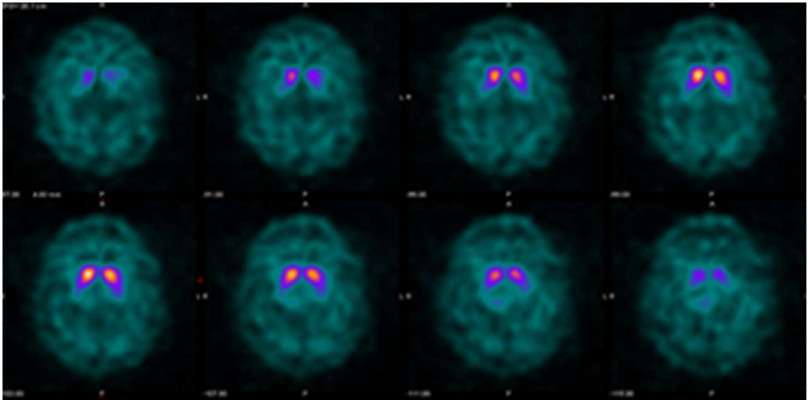
Figure 4. Example DaTQUANT results in a non-PS patient demonstrating apparent loss of the normal “comma shape”, particularly on the right. However, none of the summary measures, SBR (1.23 to 1.33), z-score ( − 0.51 to − 0.88), or percent deviations ( − 0.12 to − 0.19) meet thresholds for abnormal. The caudate nuclei are noted to have relatively increased uptake (SBR 3.10–3.45, z-score 2.42–3.48) causing an apparent decrease in putaminal activity where there is none (“hot caudate” sign).